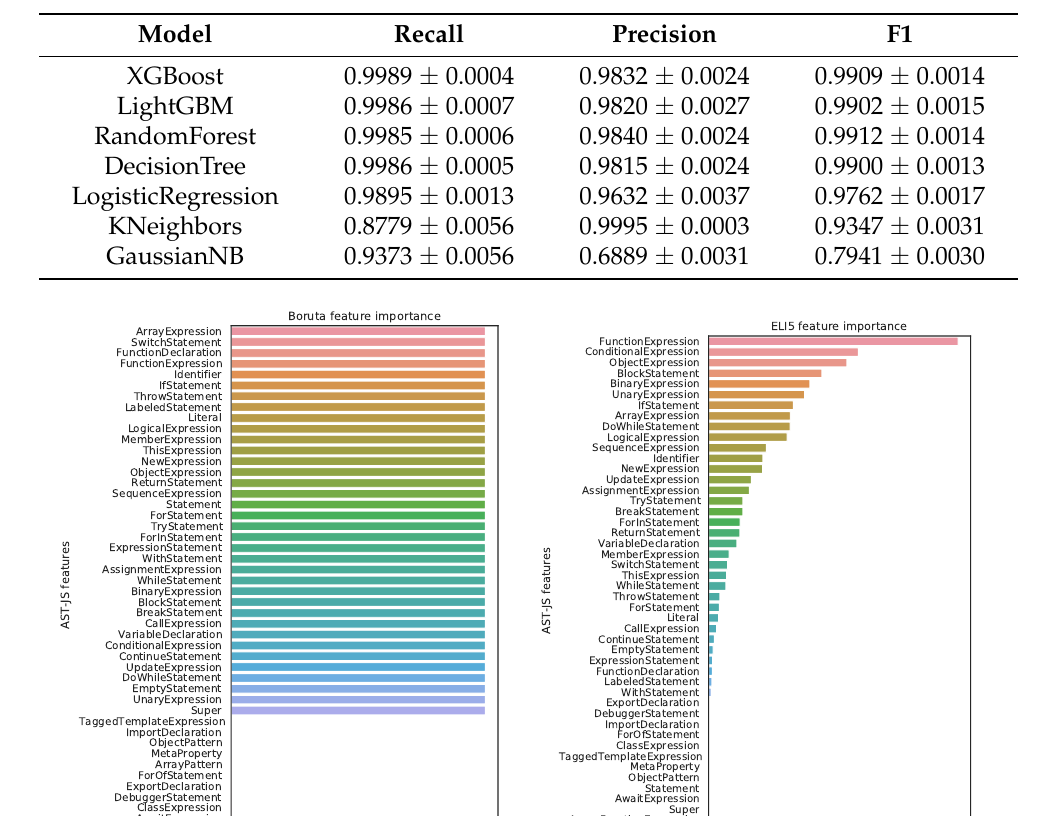
Table 4. Performance comparison using SHAP selected AST-JS features.